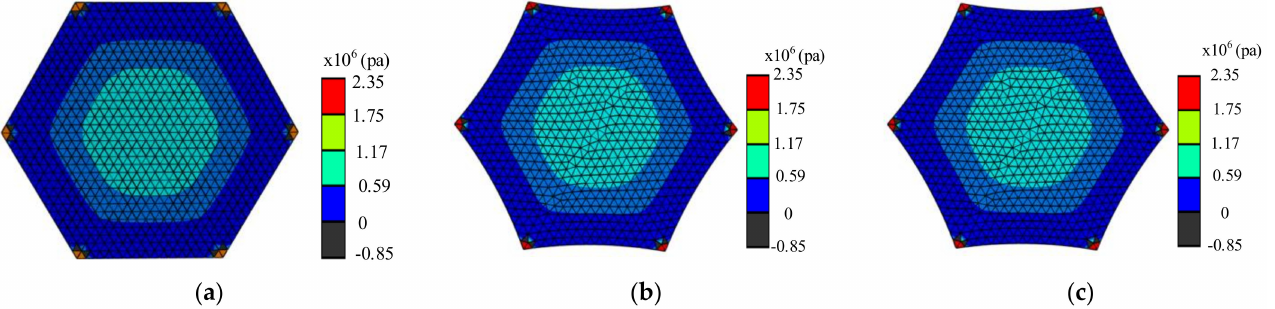
Figure 10. Distribution of the second principal stress in the membrane at different arch heights.